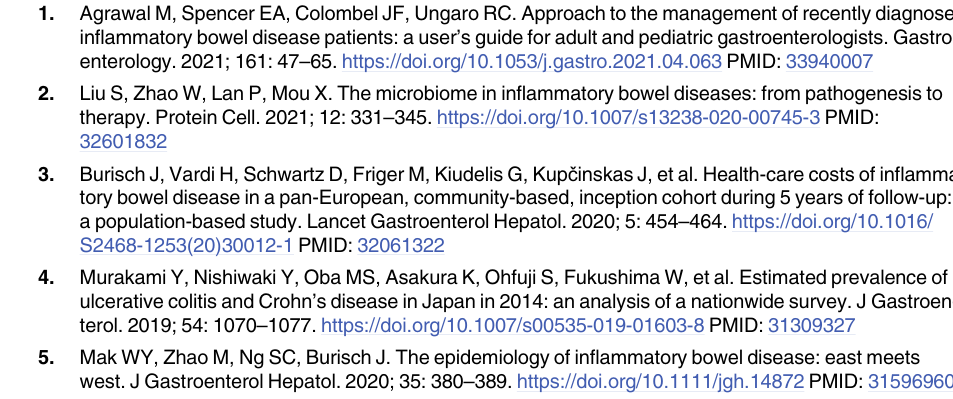
S1 Table. Search strategy for